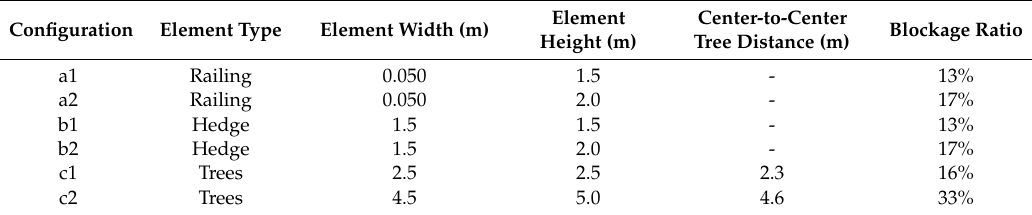
Table 2. Specifications of the railing, hedges, and trees incorporated into the skygarden model (present study).